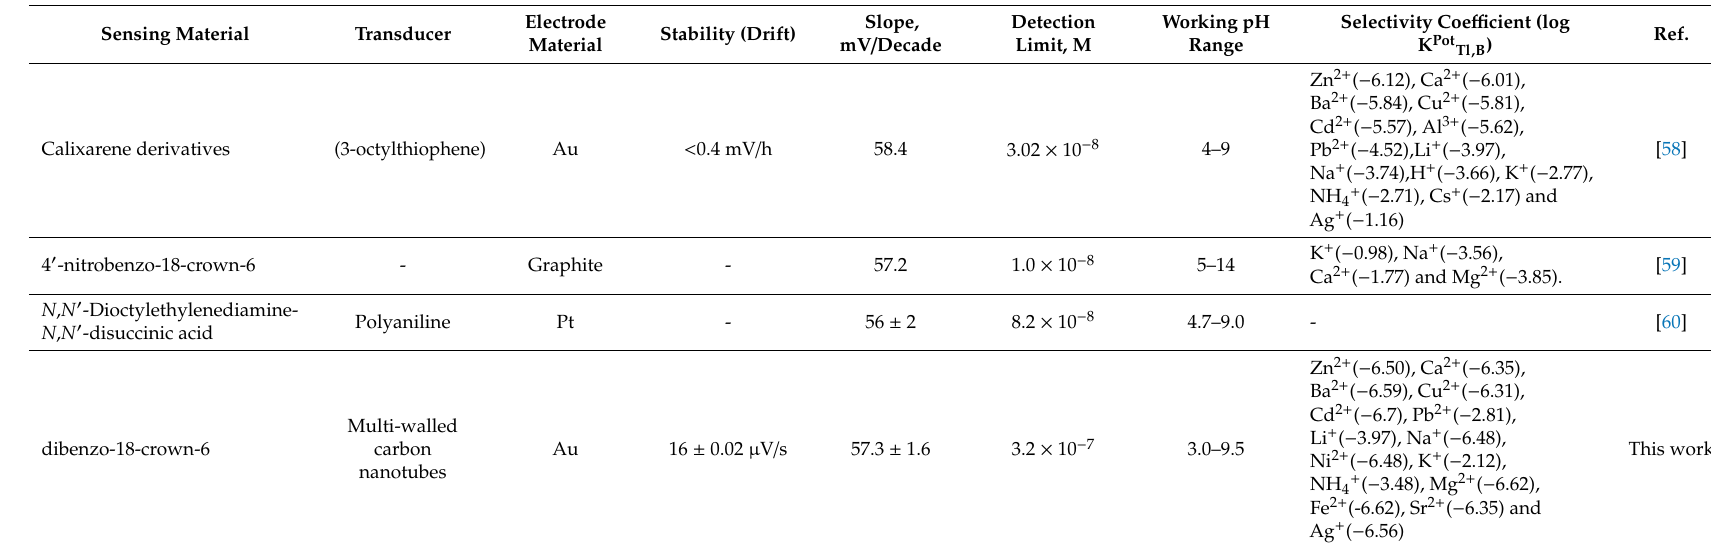
Table 3. General characteristics of some potentiometric solid-contact Tl-membrane